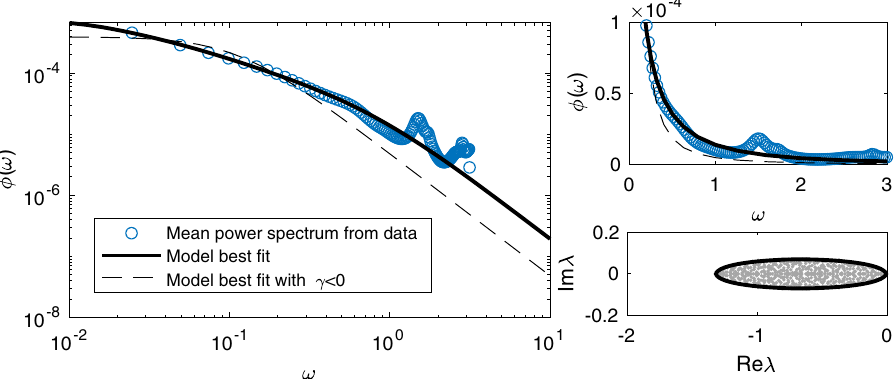
Fig. 5 Fluctuation spectra in plankton species abundance. We plot the power spectral density of data taken from 34 (blue circles) alongside that of a fi tted Lotka-Volterra random ecosystem model (solid line). Fitted parameters are b = 0.6643, c σ 2 = 0.1316, γ = 0.8078, data averaged over n = 3 samples per day. Also shown is the best fi t under the restriction γ < 0 (dashed line). The lower right panel shows the spectral boundary inferred from the fi t (black ellipse), along with the eigenvalues of a sample random community matrix for illustration.